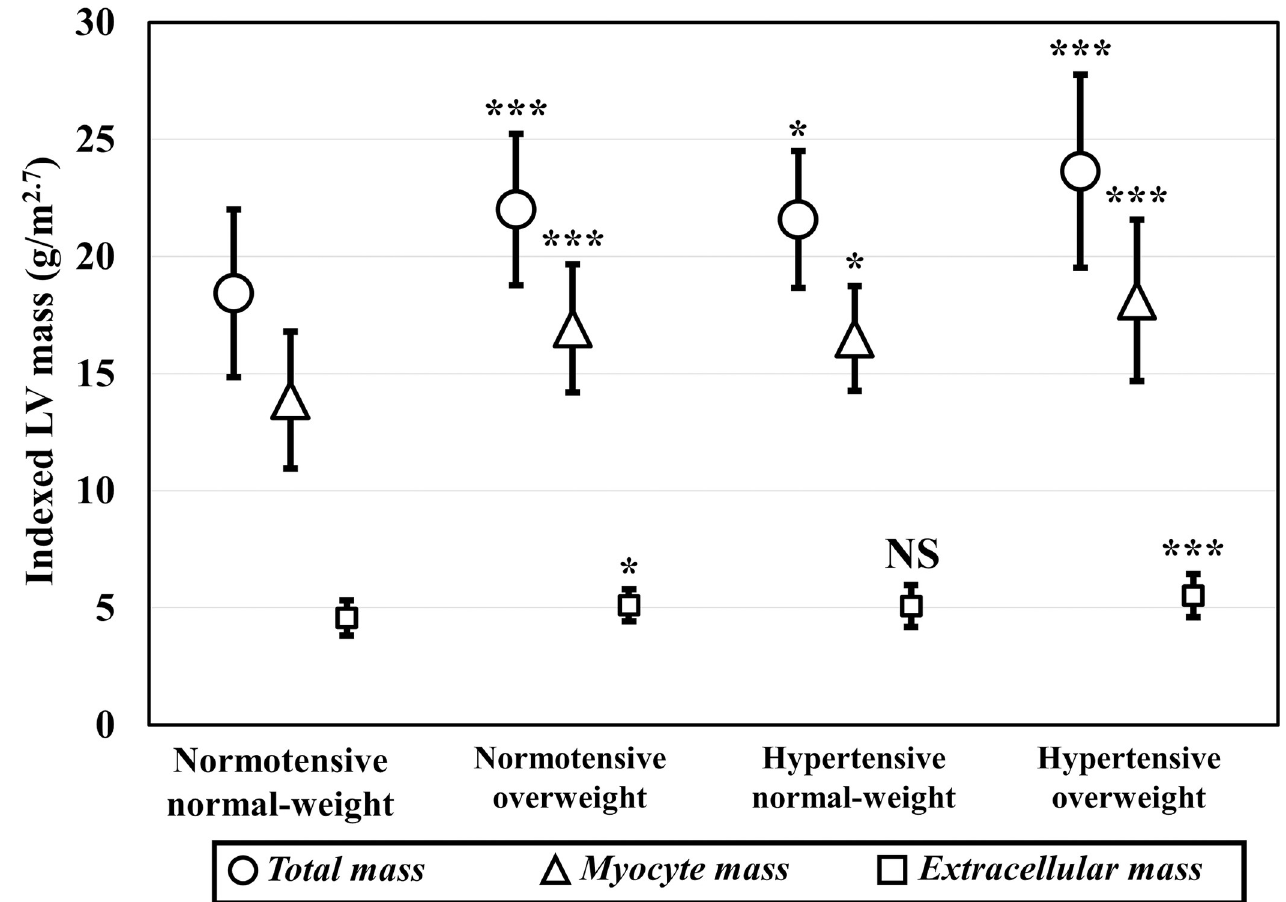
Fig 4. Left ventricular (LV) mass indexed for height to the power of 2.7 visualized as mean with standard deviation. The different markers represent total myocardial mass, myocyte mass and extracellular mass. Significantly higher values compared to the normotensive normal-weight group are P < 0.05 ( � ), P < 0.01 ( �� ) and P < 0.001 ( ��� ). NS not